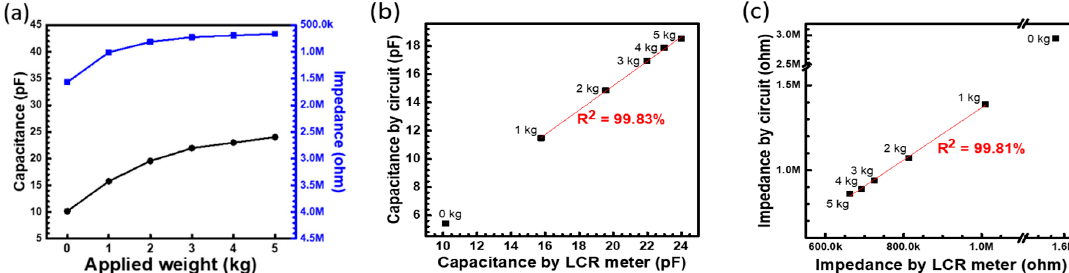
Figure 3. ( a ) Typical response between the applied weight and readout value of the single point of this pressure-sensing pad compared with impedance analyzer. ( b ) Capacitance. ( c ) Impedance correlation between the readout system and impedance analyzer.